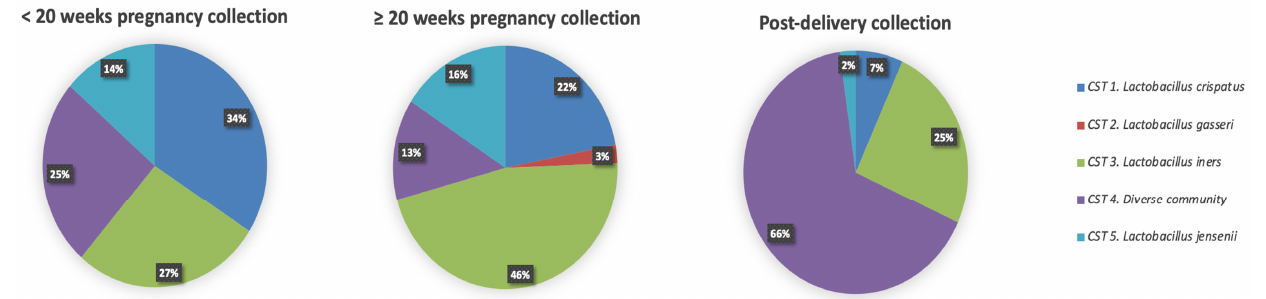
Figure 4. Frequency of five community state type (CST) identified each collection timepoint ( n = 44 at <20 weeks GA and post-delivery timepoints; n = 82 at the ≥ 20 weeks GA timepoint). In the pie charts the CST cluster is given in colour: CST I, blue; CST II, green; CST III, red; CST IV, yellow; CST V, purple. Microorganisms 2022 , 10 , x FOR PEER REVIEW